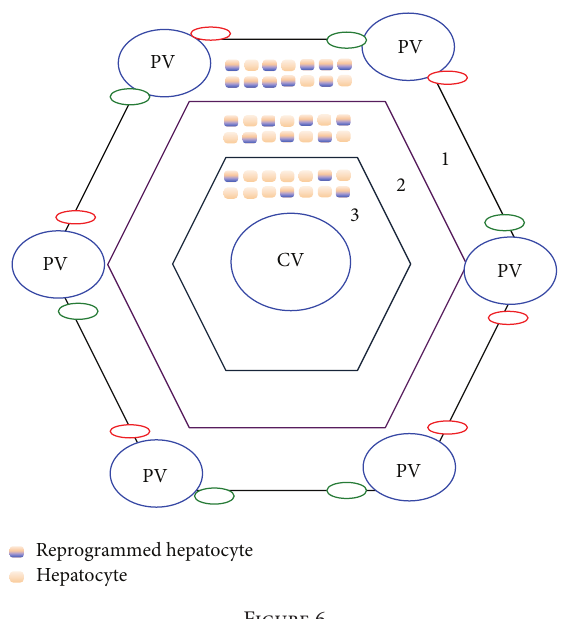
to the portal venules are in “Zone 1.” It is believed that “Zone 1” and to a lesser extent “Zone 2” hepatocytes have a higher efficiency in undergoing cellular reprogramming compared to hepatocytes around central veins also known as “Zone 3” [26, 35, 51] (Figure 6). It is interesting to note that the Notch pathway gets activated in all the zones encompassing greater than 95% of hepatocytes, but Zone 1 and Zone 2 hepatocytes undergo ductular reactions. This suggests that there are either missing signalling pathways in Zones 1 and 2 or inhibitory pathways in Zone 3 that prevent this reprogramming response. Furthermore, the extracellular milieu may also vary between the zones as hepatocytes in each zone have different metabolic functions